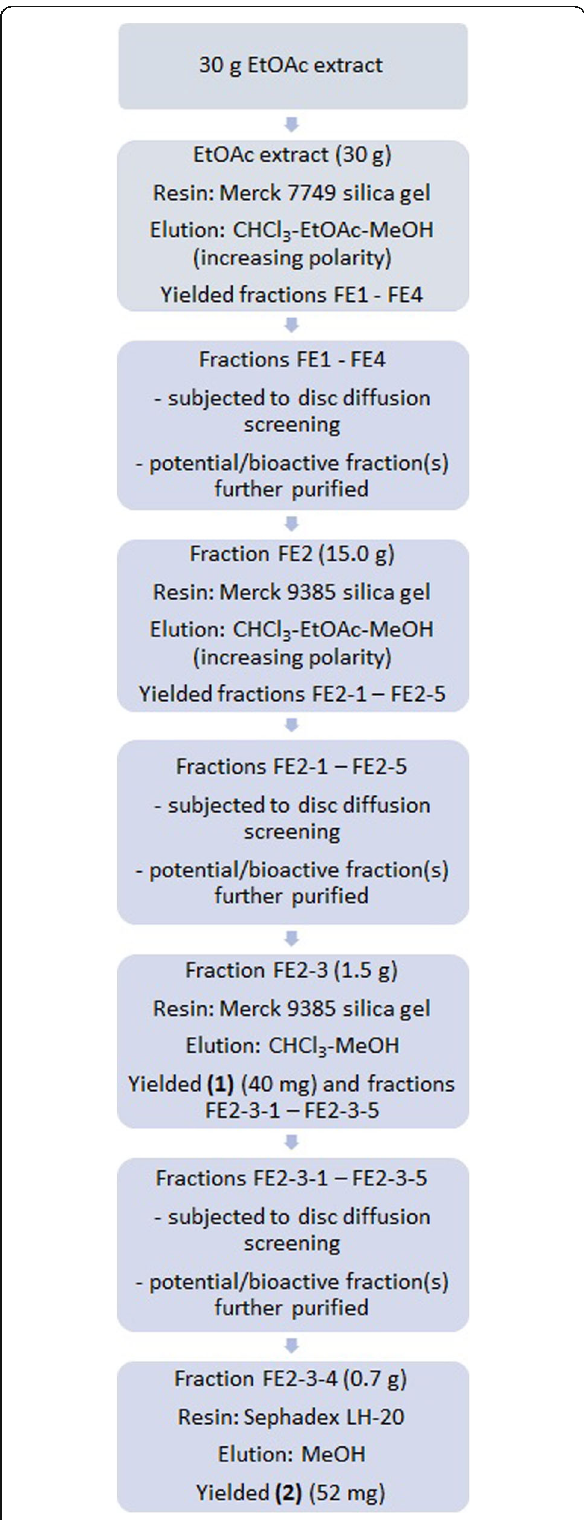
Fig. 2 Schematic diagram of fractionation and isolation of compound 1 and